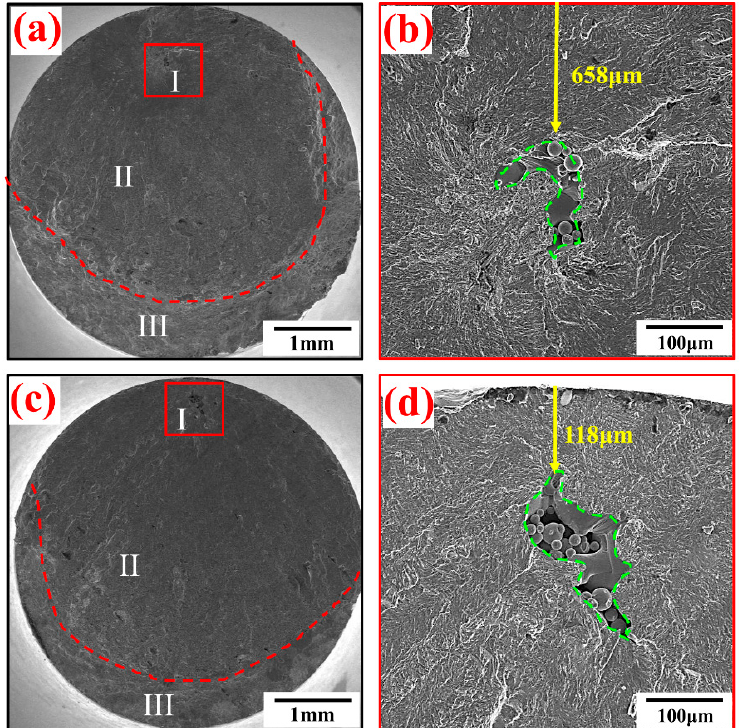
Figure 10. Macroscopic fatigue fracture surface and the crack initiation zone of different specimens: ( a , b ) 850FC (3,961,000 cycles), ( c , d ) 1050WAC (2,175,400 cycles). ( a , b ) 850FC (3,961,000 cycles), ( c , d ) 1050WAC (2,175,400